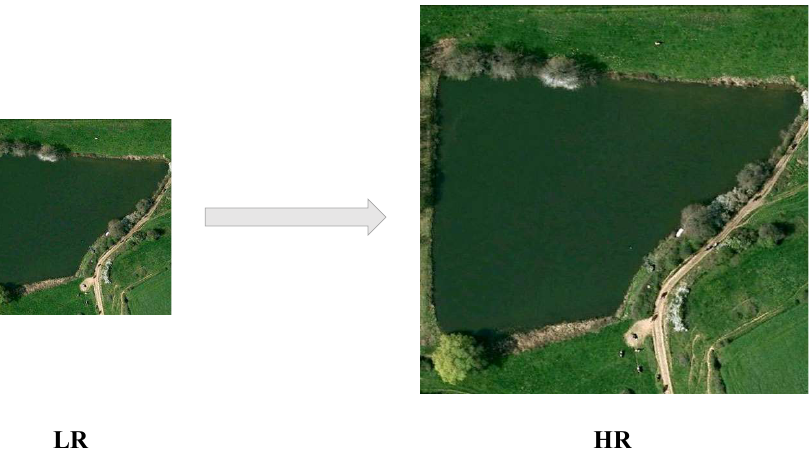
Figure 1. SR aims to reconstruct a high-resolution (HR) image from its degraded low-resolution (LR)